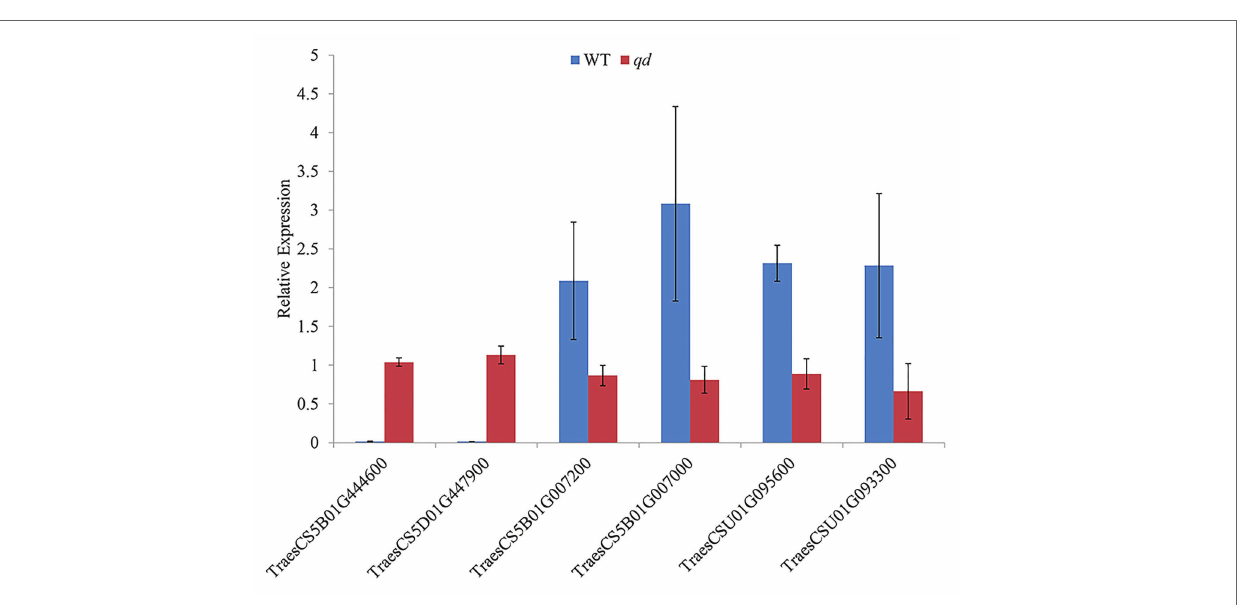
FIGURE 8 | Verification of the DEGs in the benzoxazinoid biosynthesis pathway by qPCR. Bx1 contained two DEGs, namely, TraesCS5B01G444600 and TraesCS5D01G447900. Bx3 contained one DEG, namely, TraesCS5B01G007200. Bx5 contained one DEG, namely, TraesCS5B01G007000. Bx8_9 contained two DEGs, namely, TraesCSU01G095600 and